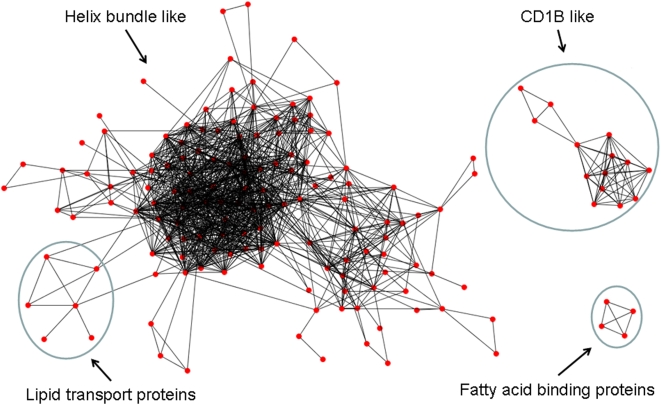
The three largest clusters of the off-target network formed from their global structural similarities.Each node in the graph represents one off-target as found in supplemental material Table S1. Two nodes are connected by an edge if their global structures are similar (measured by a CE [104] z-score larger than 4.0).